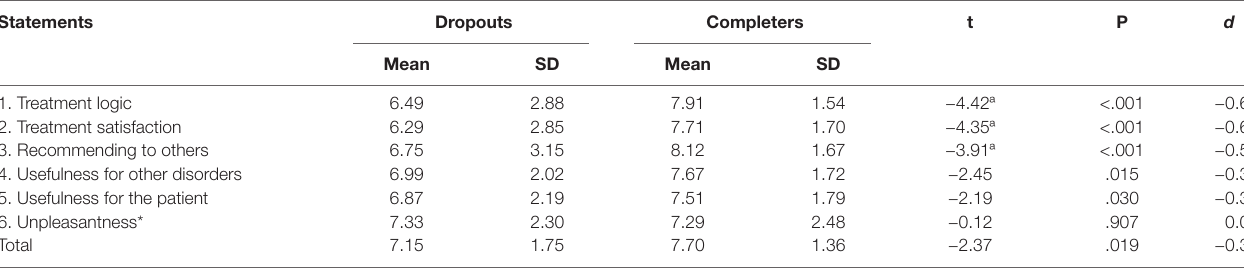
TABLE 4 | T-tests comparing expectations of dropouts and